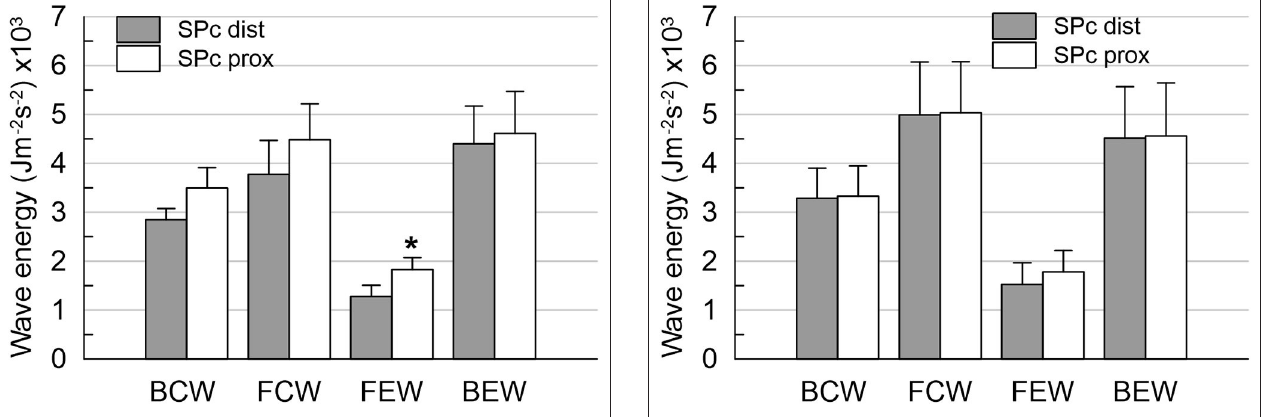
Frontiers in Cardiovascular Medicine |